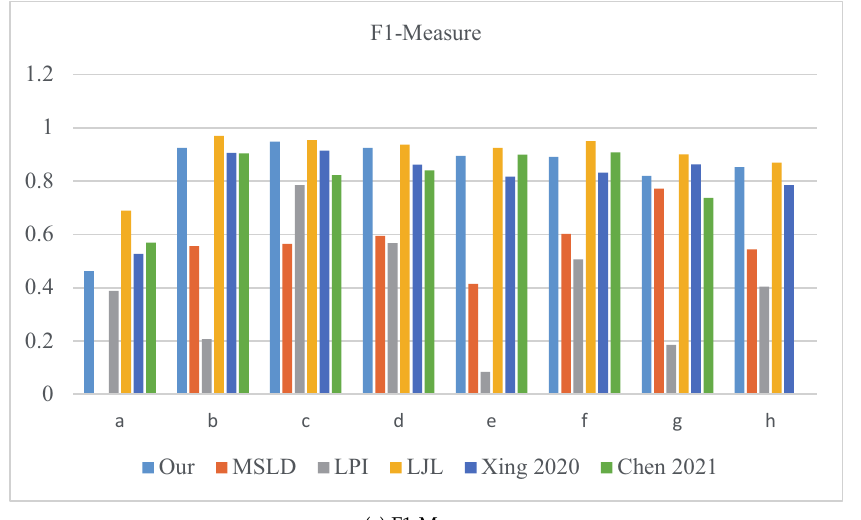
Figure 10. ( a – c ), respectively, show the comparison of our method, MSLD, LPI, LJL, reference [11] (2020) and reference [22] (2021) in precision, recall, and F1-Measure. It is worth noting that results on the occlusion image pairs is missing from reference